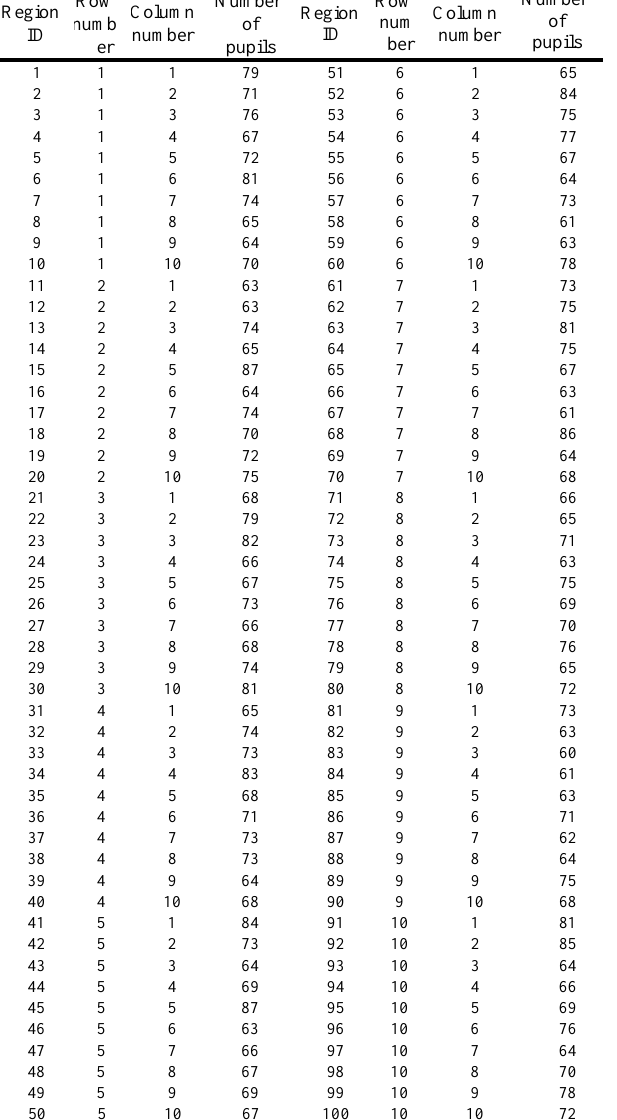
Table 2. Table 1. The characteristics of 100 sampled regions